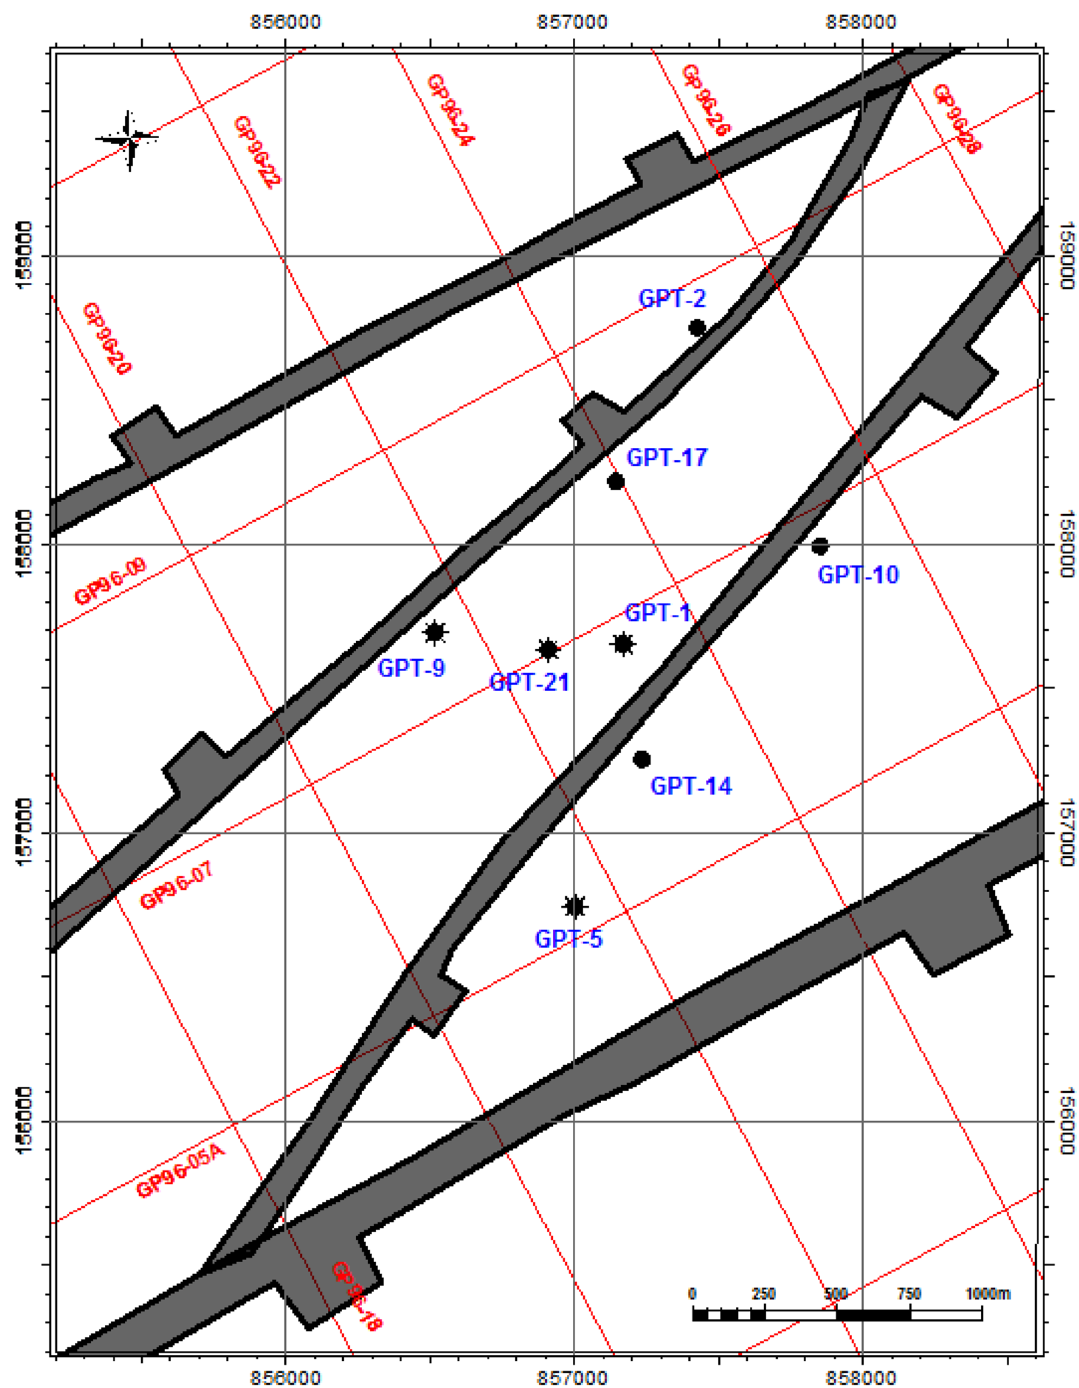
Fig. 11 Base map showing the modeled faults in the study area (top Abu Roash D